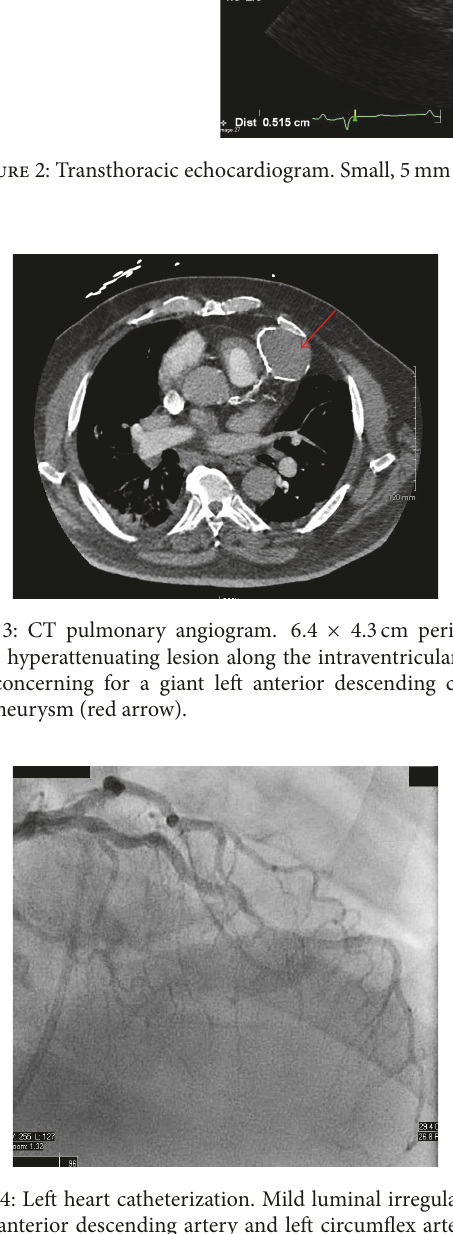
Figure 4: Left heart catheterization. Mild luminal irregularities of the left anterior descending artery and left circumflex arteries not requiring percutaneous intervention. No evidence of aneurysm.